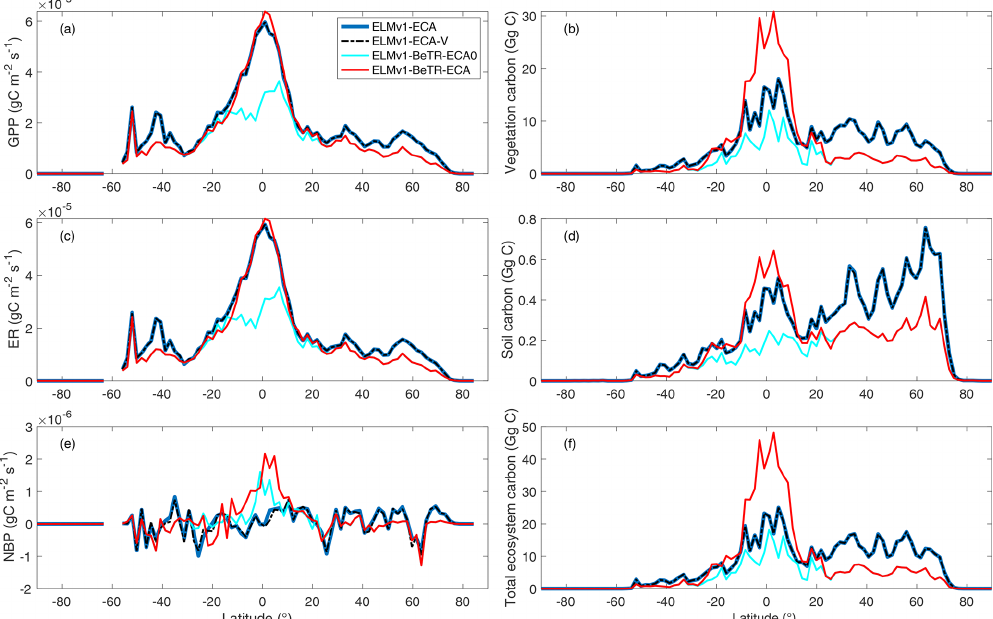
Figure 3. Comparison of simulated flux and state variables at the end of the 200th year during the accelerated spinup for four model configurations (see Table 1). ELMv1-ECA-V differs from ELMv1-ECA as it uses the multiple-flux co-limiting solver for allocating carbon and nutrients for plant growth. ELMv1-BeTR-ECA0 differs from ELMv1-ECA-V by further solving belowground nutrient competition using the multiple-flux co-limiting solver. ELMv1-BeTR-ECA differs from ELMv1-BeTR-ECA0 by using re-calibrated parameters for two tropical plant functional types: broadleaf evergreen tropical trees and broadleaf deciduous tropical trees. We note that the soil carbon here is smaller than vegetation carbon because factors of accelerated decomposition have not been applied. Table 2. Comparison of calibrated (ELMv1-BeTR-ECA) and default (ELMv1-ECA) parameters. PFT-4 is a broadleaf evergreen tropical tree and PFT-6 is a broadleaf deciduous tropical tree. Parameters ELMv1- ECA ELMv1-BeTR-ECA PFT-4 PFT-6 PFT-4 PFT-6 Maximum nitrogen fixation rate (s − 1 ) 1 . 55 × 10 − 9 Plant affinity for soil NH + (gNm − 3 ) 0.14 4 Plant affinity for soil NO − (gNm − 3 ) 0.27 3 Maximum plant uptake rate for NH + (s − 1 ) 4 Maximum plant uptake rate for NO − (s − 1 ) 3 Fixed N 2 fraction directly entering